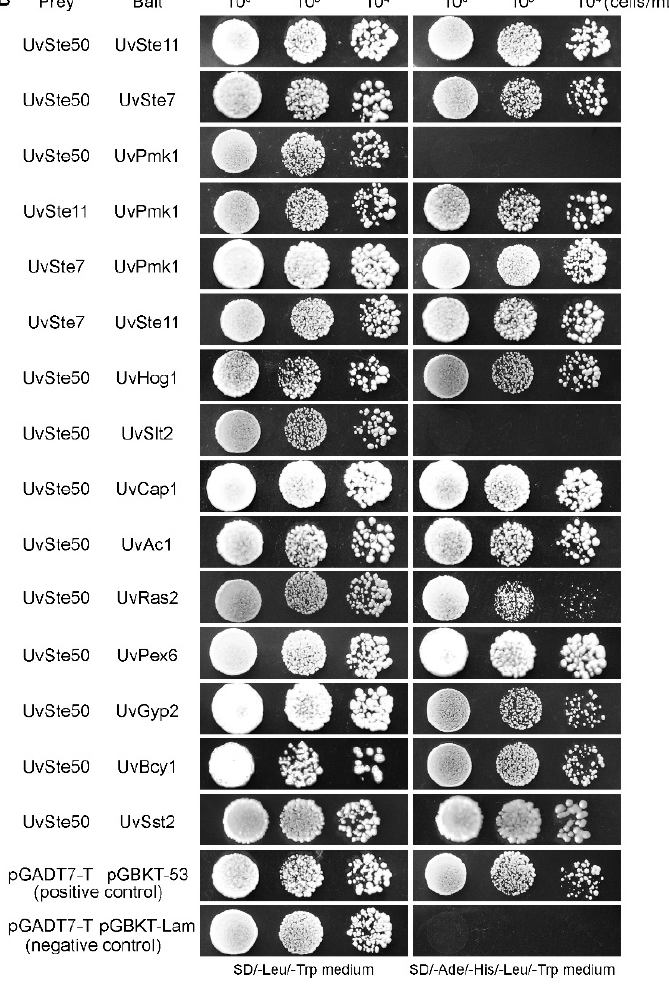
Figure 9. Assays for interactions between UvSte50 and other proteins in U. virens . ( A ) Sub-cellular localization of UvSte50 in U. virens . Vegetative hyphae of transformant expressing UvSte50-GFP were observed under confocal fluorescence microscopy. Bar, 10 µ m. ( B ) A yeast two-hybrid assay was performed to examine the interaction between UvSte50 and other proteins in U. virens . Yeast cells (10 4 –10 6 cells/mL) of transformants containing prey and bait vectors were assayed for growth on SD/-Leu/-Trp and SD/-Ade/-His/-Leu/-Trp